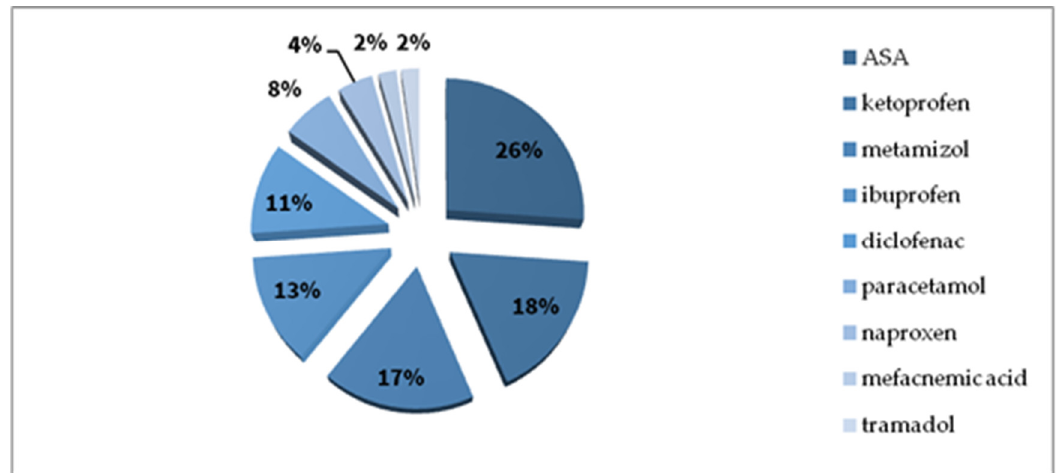
Figure 8. Nonsteroidal anti-inflammatory drug (NSAID) causes of anaphylaxis in the study whole group (%).